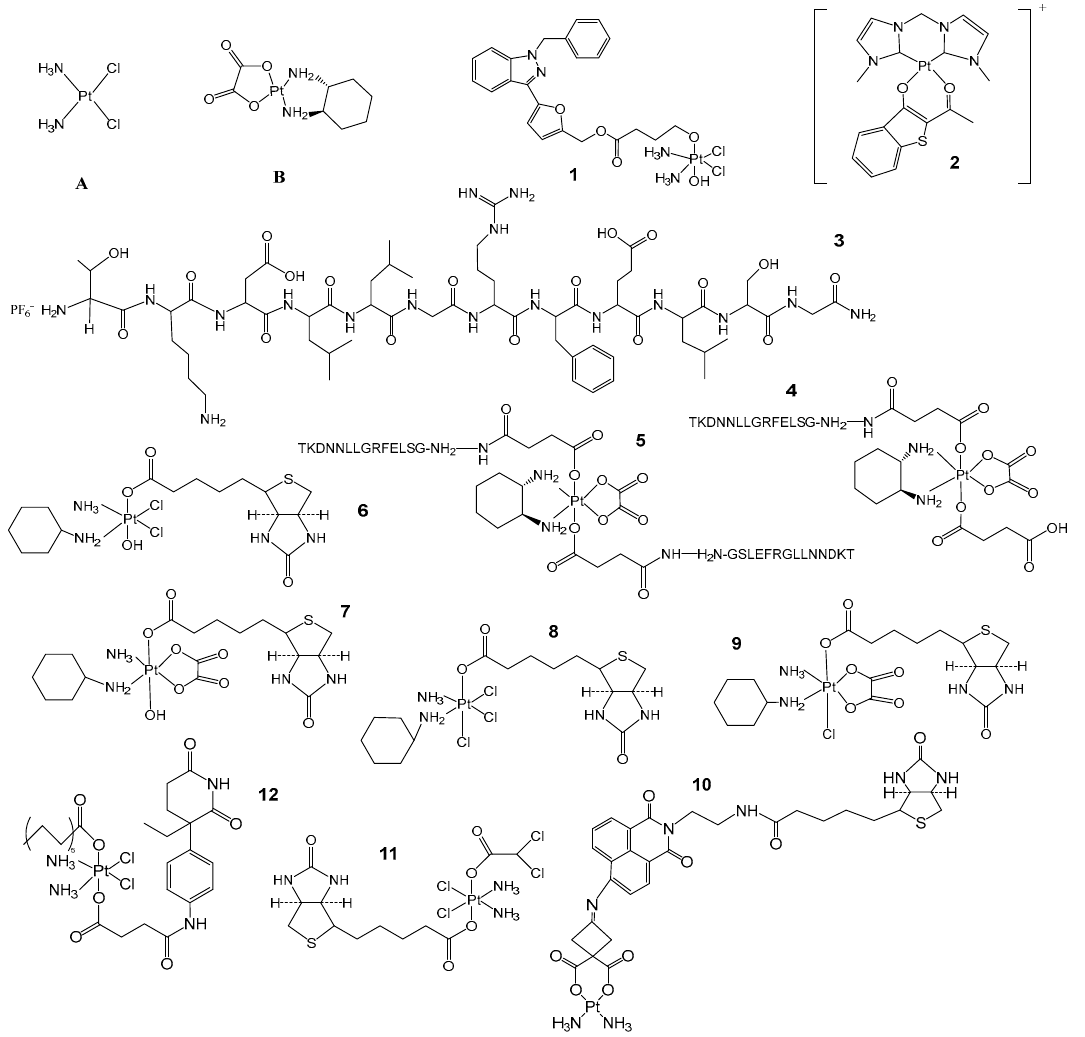
Figure 2. Improving drug targeting properties by structural modification of Pt(II) and Pt(IV) prodrugs. ( A ) Structure of cisplatin. ( B ) Structure of oxaliplatin. ( 1 ) YCC-2. ( 2 ) Complex [(bis- NHC)Pt(bt)]PF6 1 α ( 3 , 4 , 5 ) compounds designed by A.M. Mckeon’s group to target membrane sur- face heat shock protein 70+. ( 6 , 7 , 8 , 9 ) Pt(IV) complexes designed by Gao’s group with biotin as the axial group. ( 10 ) Biotin-modified Pt(IV) complex designed by Chen’s group. ( 11 ) DPB structure. ( 12 ) Dual-targeted Pt(IV) complexes designed by Liu‘s group. Reprinted with permission from Ref. [18 ,19,21-25 ].